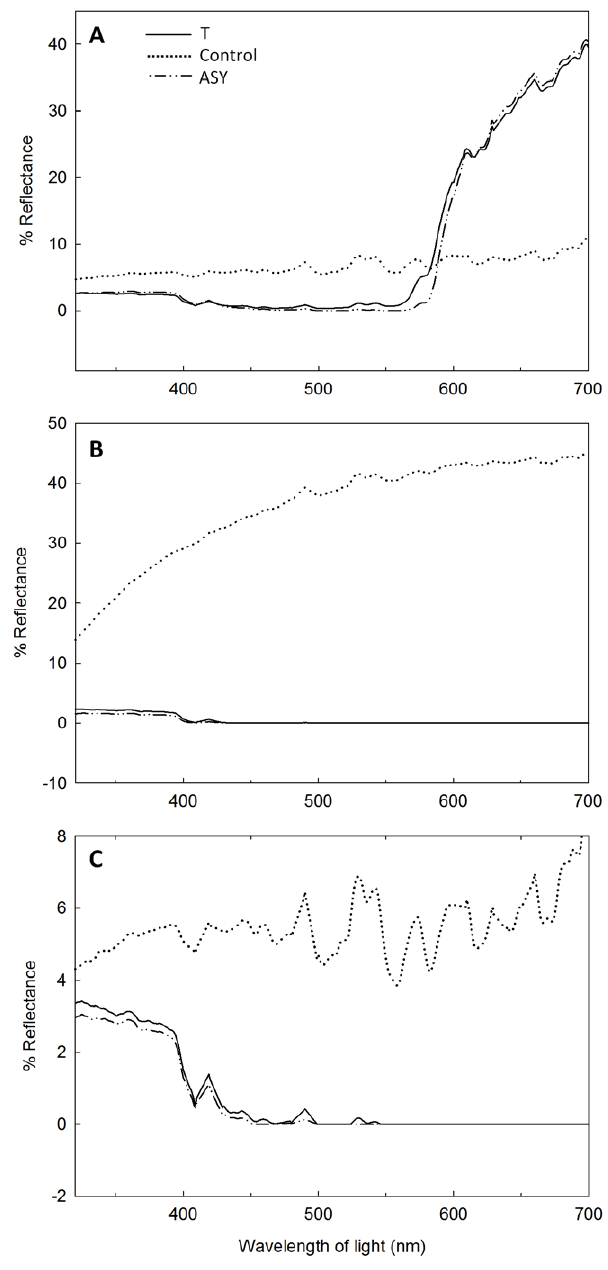
Figure 3. Reflectance spectra of back (A), breast (B), and crown (C) feathers. Lines indicate mean reflectance from testosterone (T, N=6), control (N=6), and after-second year (ASY, N=4) males from whom feathers were collected at implant